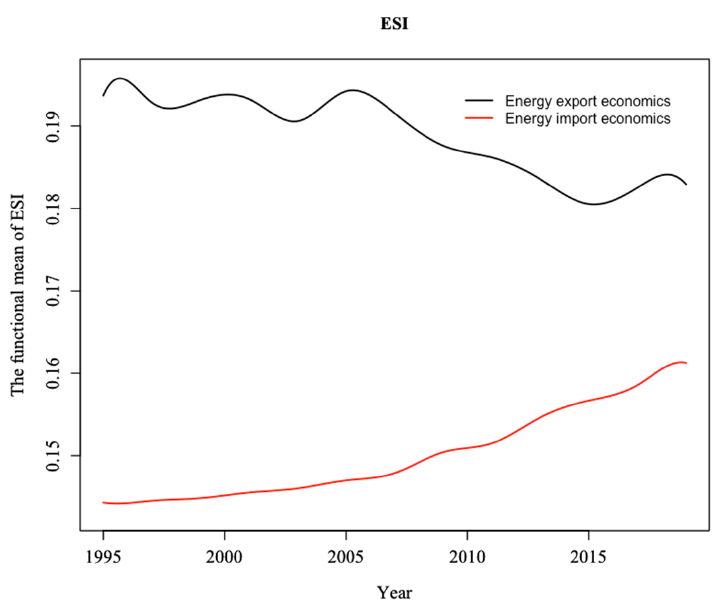
Figure 6. Trends in energy security indices for energy importing and exporting economics.